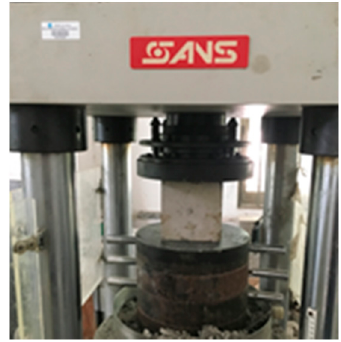
Figure 2. Experimental equipment.